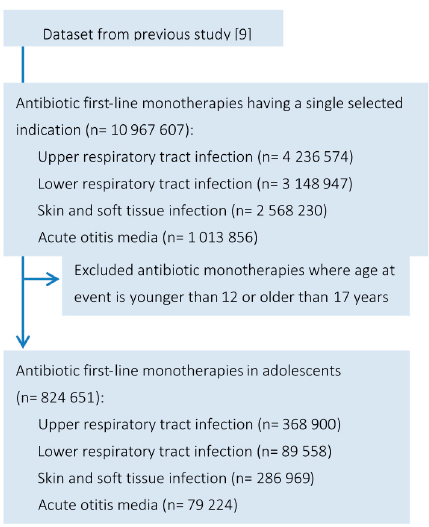
Figure 1. Data flow diagram for selection of antibiotic monotherapies in adolescents reported in the Clinical Practice Research Datalink.